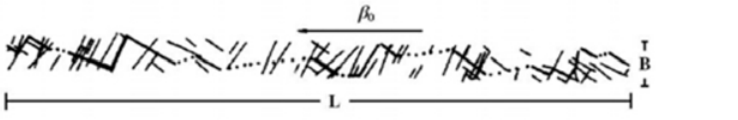
Fig 2. The failure path of joints and rock bridges